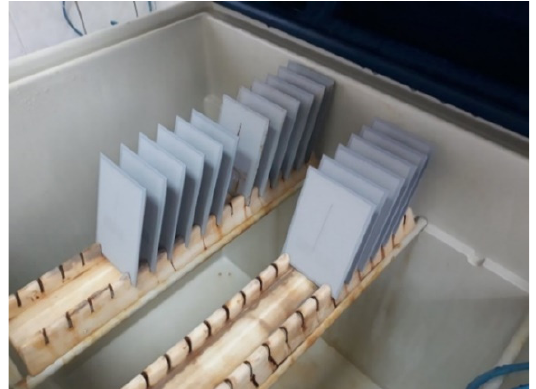
Figure 5. Test specimens inside the salt chamber workspace.